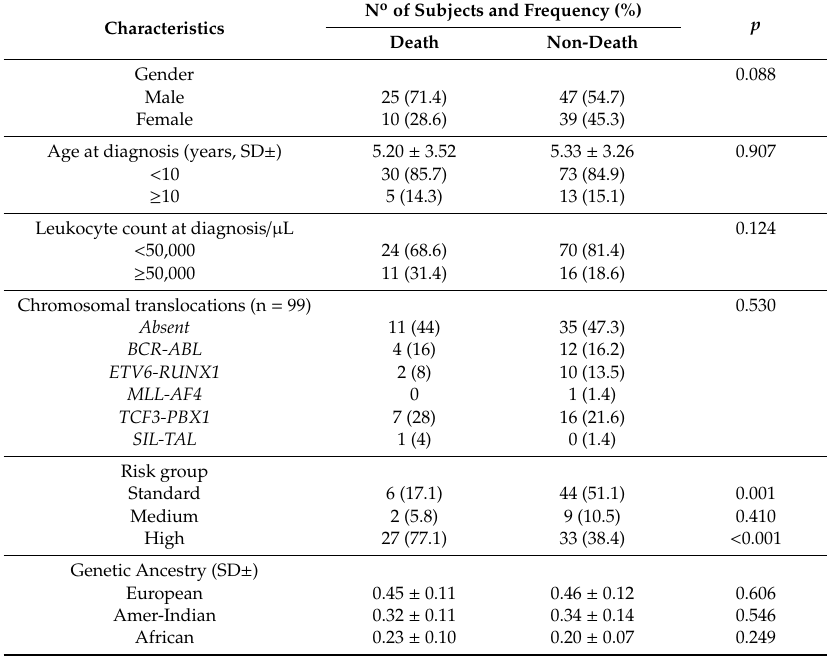
Table 3. Clinical characteristics of the patients by the death rate in the treatment of childhood ALL.